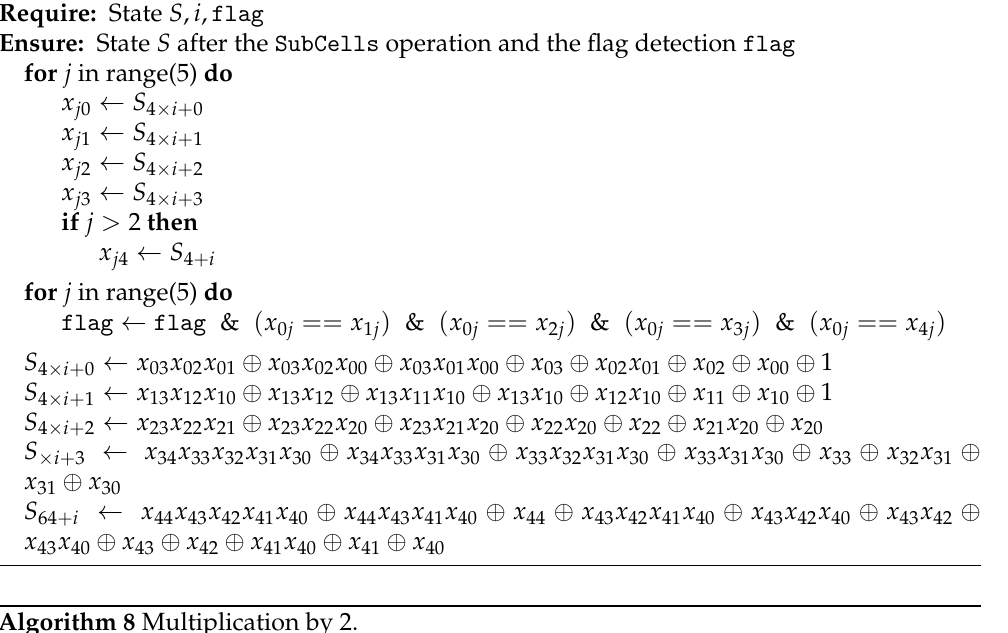
Algorithm 7 SubCells function.